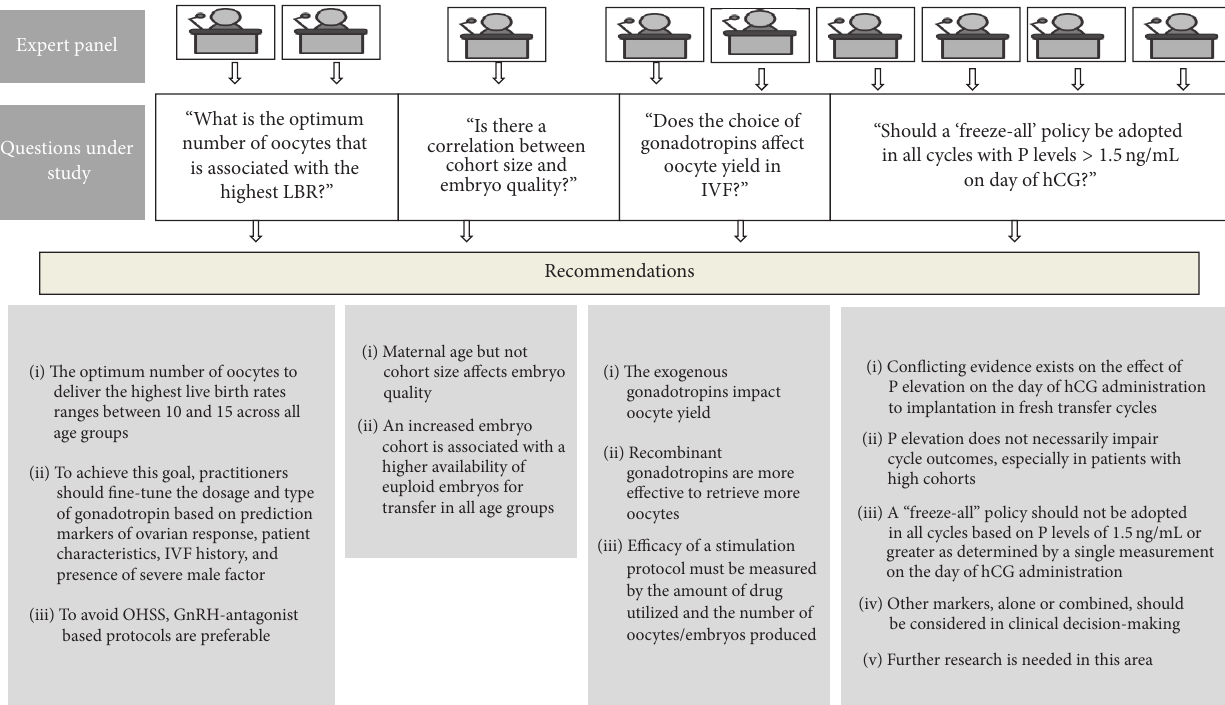
Figure 2: Composition of expert panel, questions under study, and